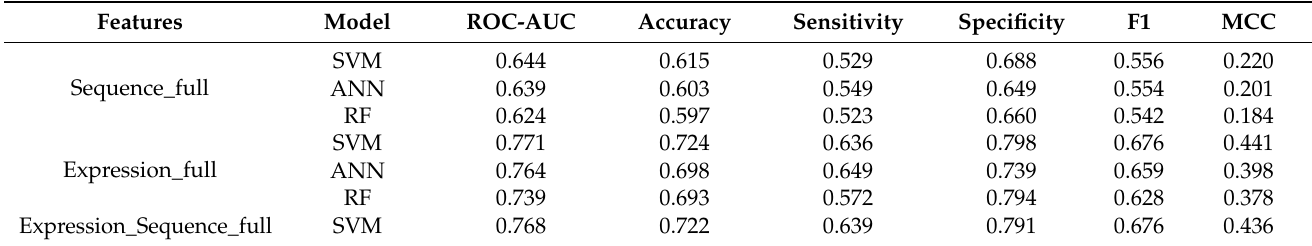
Figure 2. ROC ( A ) and PR ( B ) curves of different machine learning models using sequence and expression features. Model performance is based on five repetitions of 10-fold cross-validations, and the area under the curve (AUC) for each model is given in the legend. Table 1. Performance metrics of models using different features and learning algorithms. Support vector machine (SVM), artificial neural network (ANN), and random forest (RF) models achieved better performance using the expression features than the sequence features based on five repetitions of 10-fold cross-validations.